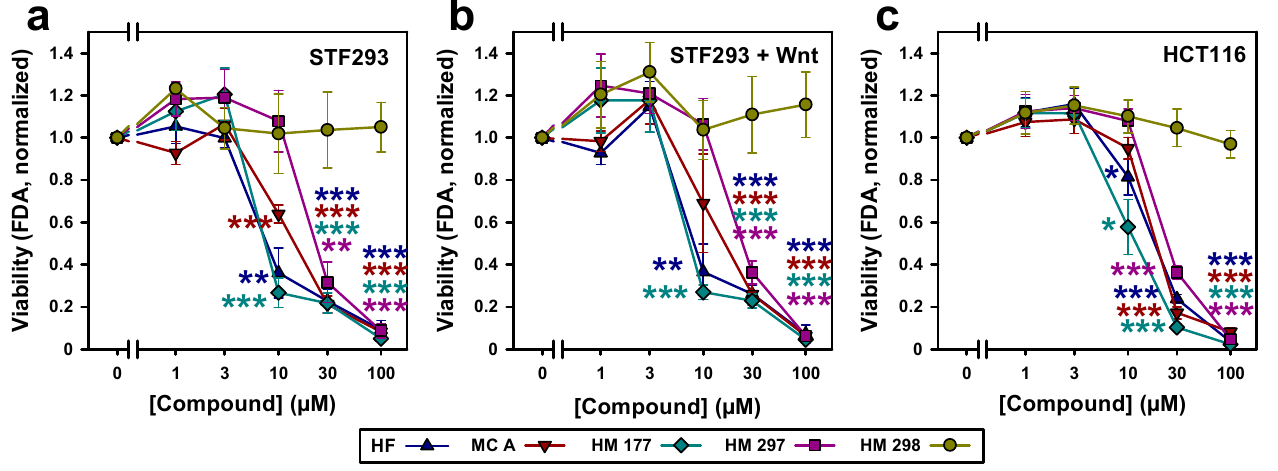
Figure 3. Analysis of cell viability in response to treatment with the indicated concentrations of HF, MC A and its derivatives HM 177, HM 297 and HM 298 on ( a ) STF293 ( n = 3; two-tailed Student’s t -test) and ( b ) STF293 cells after stimulation with Wnt3a-conditioned medium ( n = 3; two-tailed Student’s t -test) and ( c ) HCT116 cells ( n = 7; Mann–Whitney rank sum test) using FDA assays. Each value was measured in duplicate. * p < 0.05 ** p < 0.01; *** p <